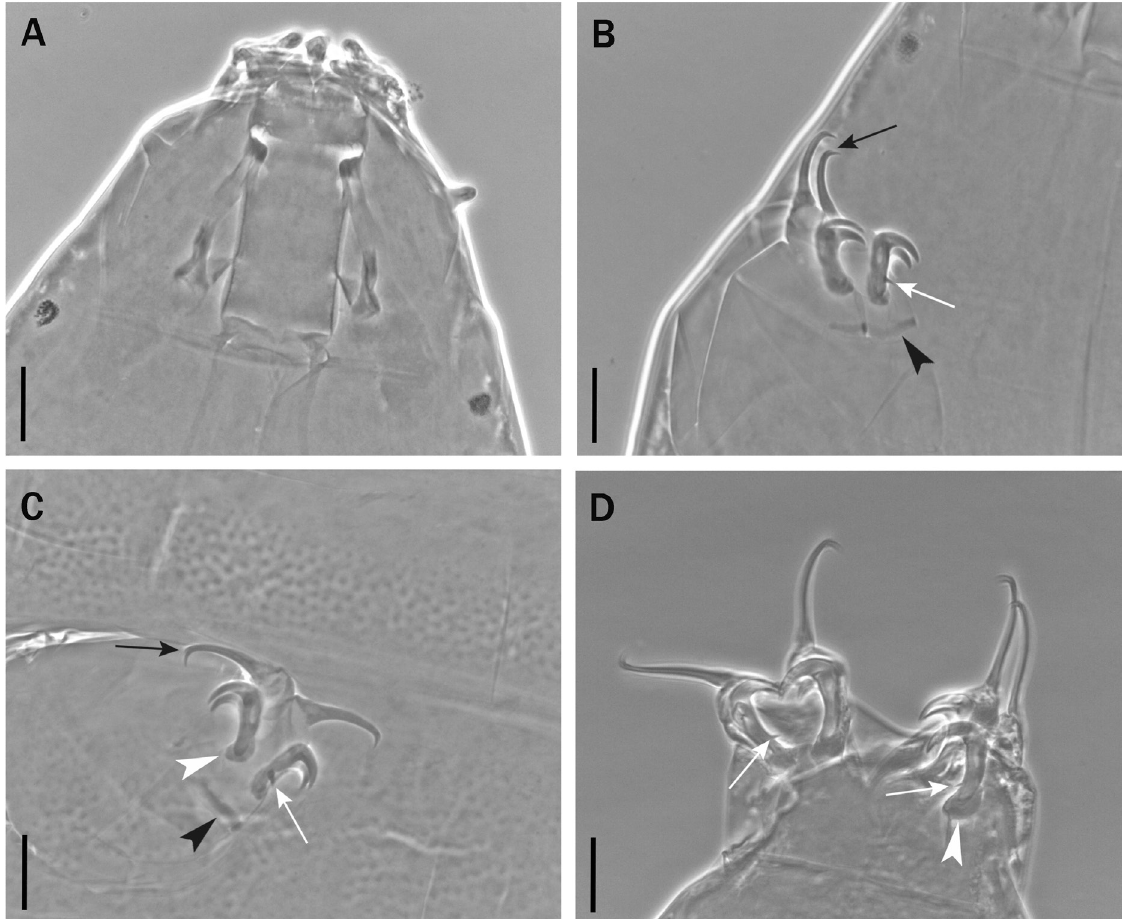
Fig. 12. Milnesium pelufforum sp. nov., holotype, ♀ (slide No. MCNS tar. 000021-3). Cephalic region and claws. A . Cephalic region with the buccal tube and related structures in focus. B . Claws of legs I. C . Claws of legs III. D . Claws of legs IV. In B–D the black arrows indicate the accessory points, the white arrows indicate the basal spurs, the white arrowheads indicate the ‘lunulae’, the black arrowheads indicate the leg cuticular bars. Scale bars = 10